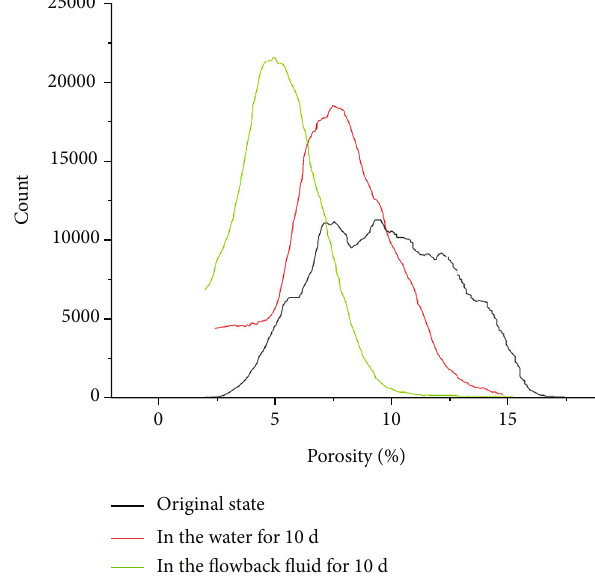
Figure 10: Change of shale porosity under di ff erent